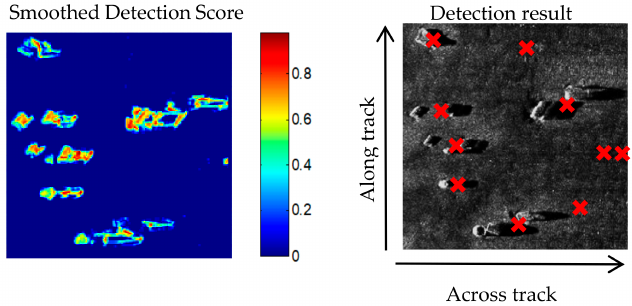
Figure 11. The multi-target detection score and detection result by the traditional DM method. The raw image is from [21].